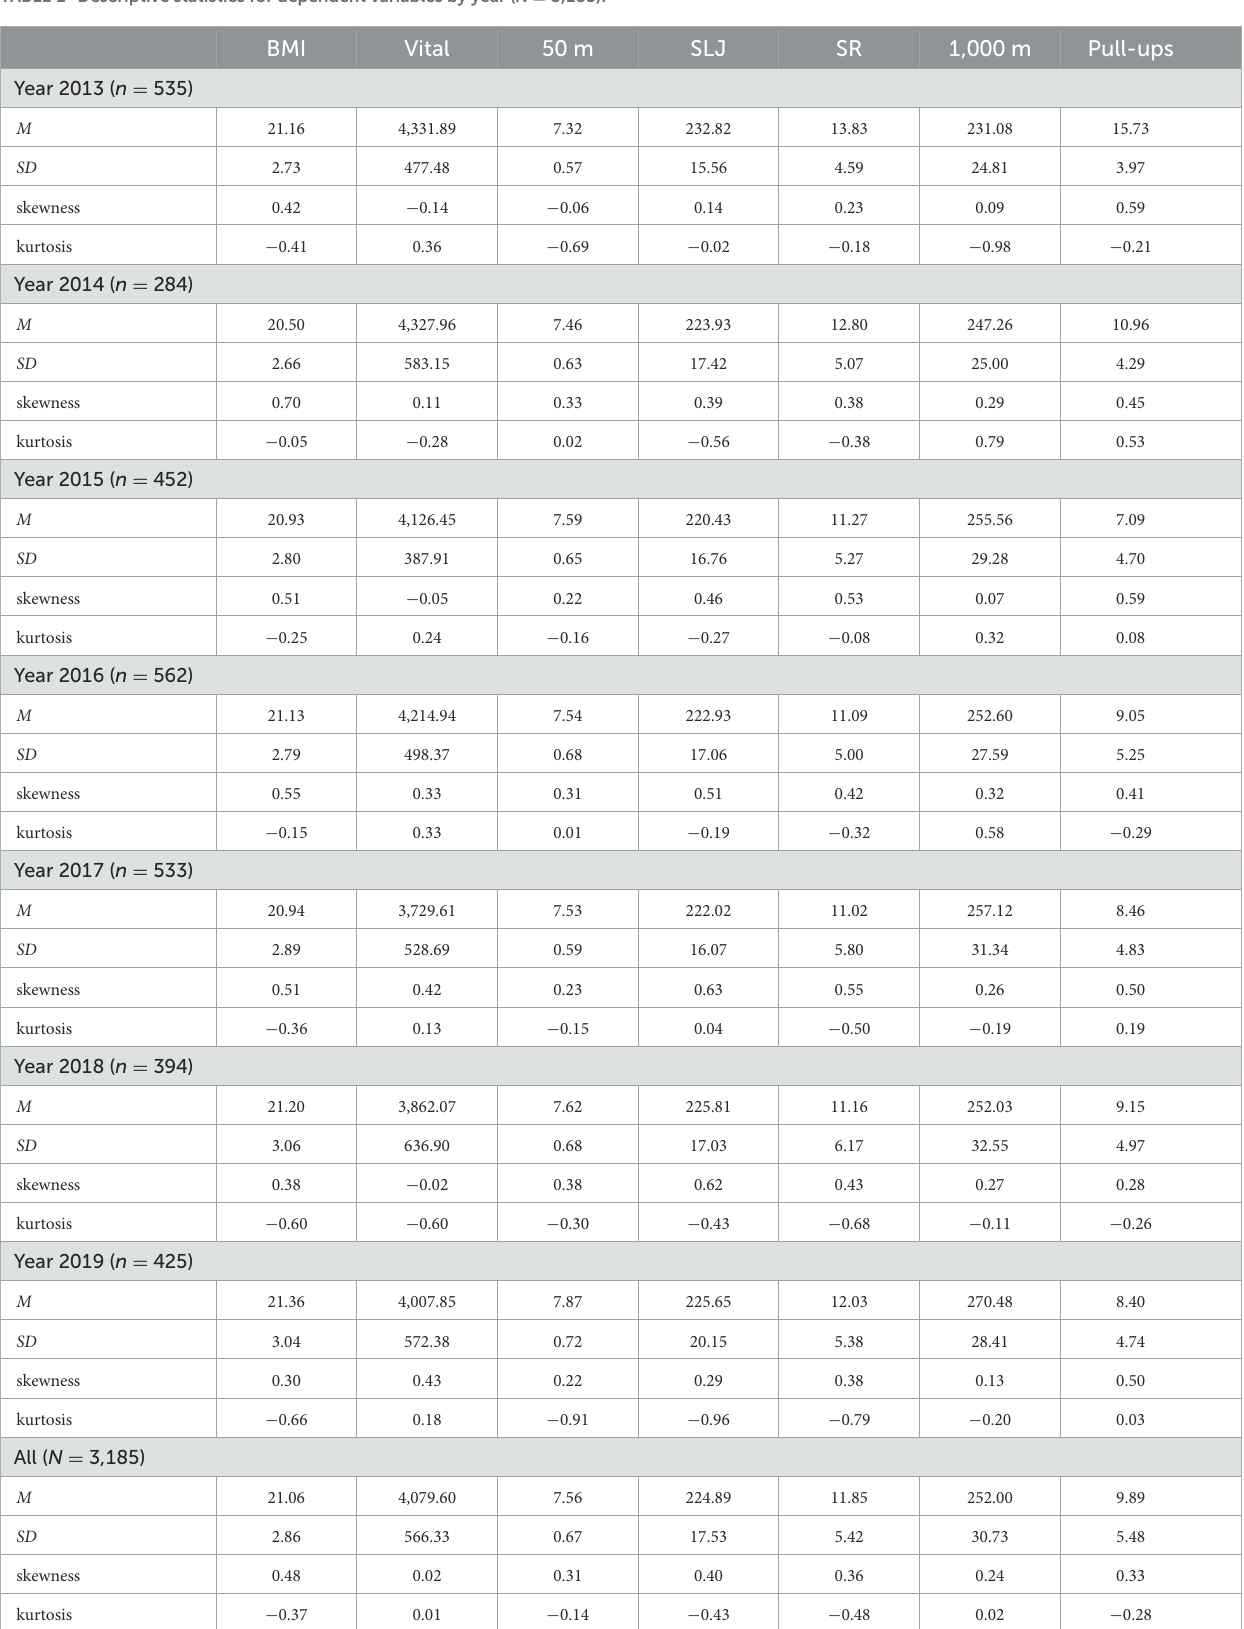
TABLE 1 Descriptive statistics for dependent variables by year ( N =